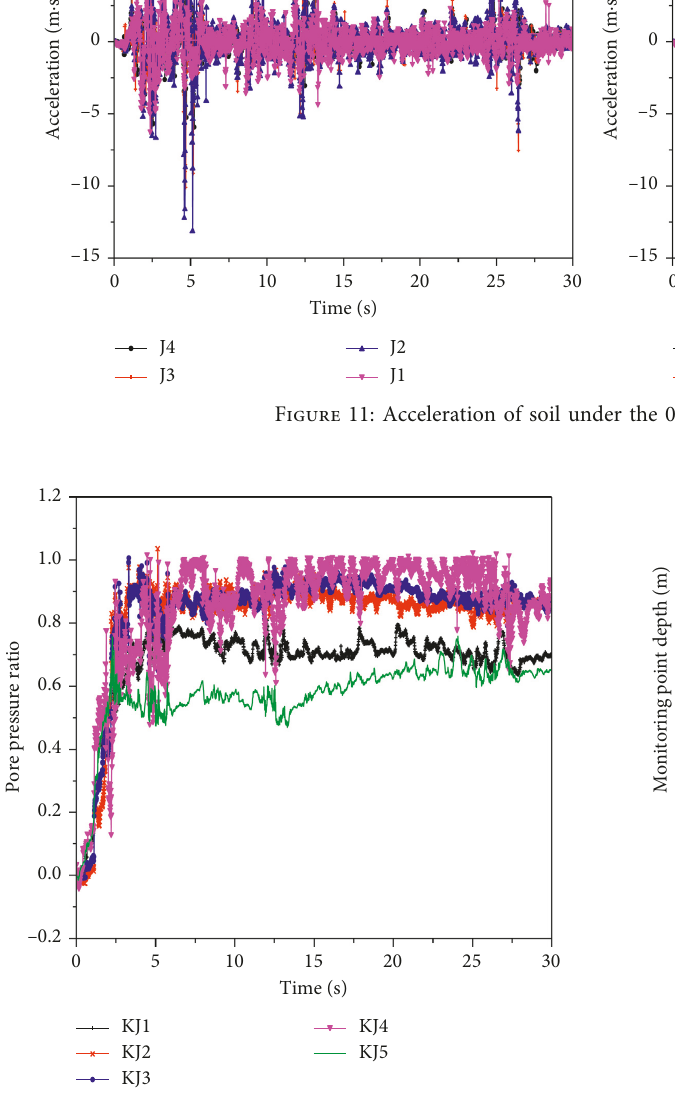
Figure 12: Time-history curves of the pore pressure ratio.